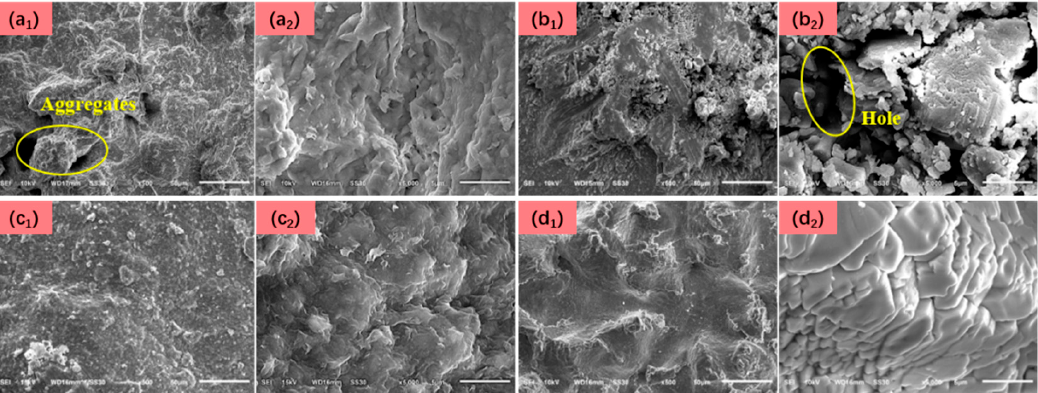
Figure 10. SEM image of the filter cake: ( a 1 , a 2 ) BT-DF; ( b 1 , b 2 ) BT-DF + 20 wt% NaCl; ( c 1 , c 2 ) BT-DF2 and ( d 1 , d 2 ) BT-DF2 + 20 wt% NaCl.